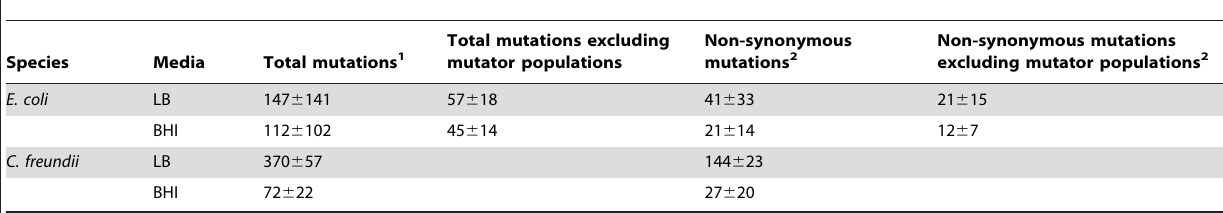
Table 1. Average number of mutations in the four different treatments.